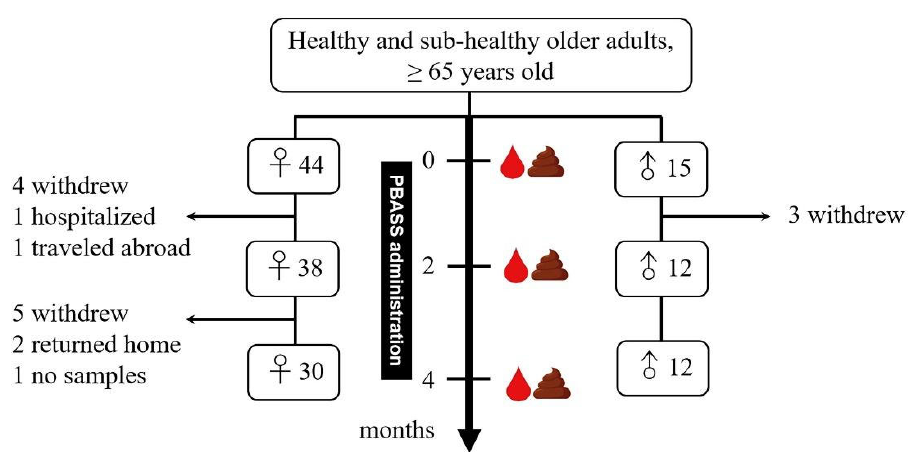
Figure 1. Flow diagram of study participants and study scheme. PBASS: plant ‐ based, antioxidant ‐ rich snacks. Blood and fecal samples were collected at the baseline and after 2 and 4 months of PBASS consumption.